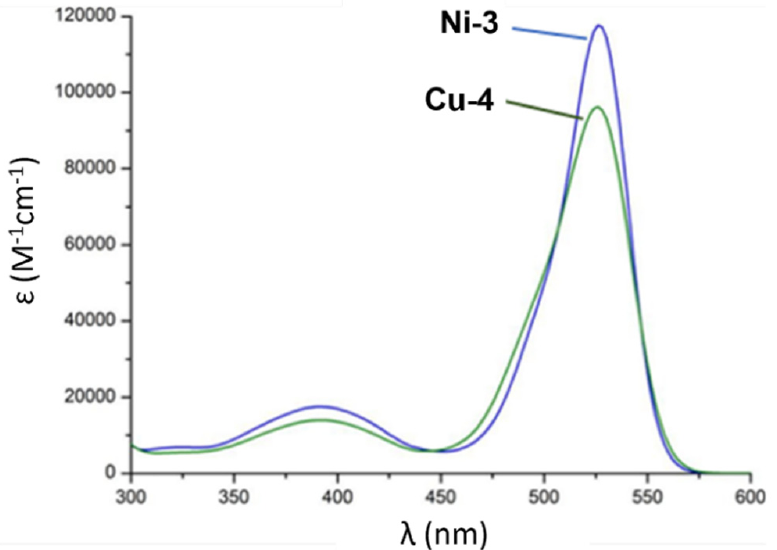
Figure 26. UV-vis absorption spectra of Ni-3 and Cu-4 in DCM. Reproduced with permission from [15]. Copyright © 2020 Elsevier B.V.